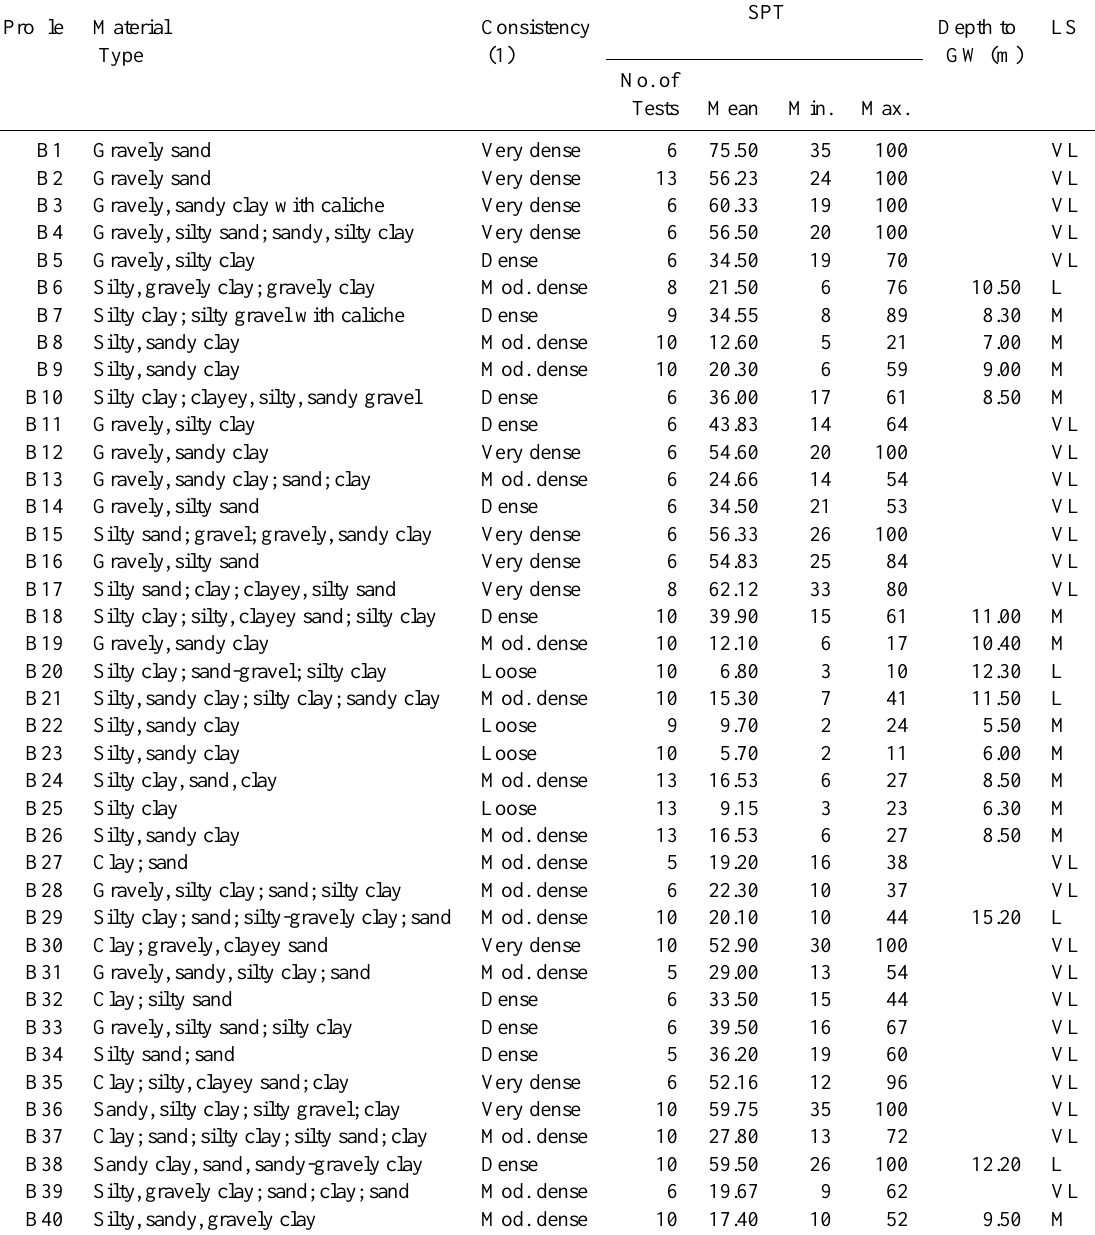
Table 2. General geotechnical characteristics and liquefaction susceptibility (LS) of Quaternary geological units in the Konya sub-basin ((1) based on the procedure Hunt, 1984). Comparative liquefaction susceptibility of units is a function of material type, SPT N-values and ground water (GW) depth in that unit. M: moderate, L: low, and VL: very low to